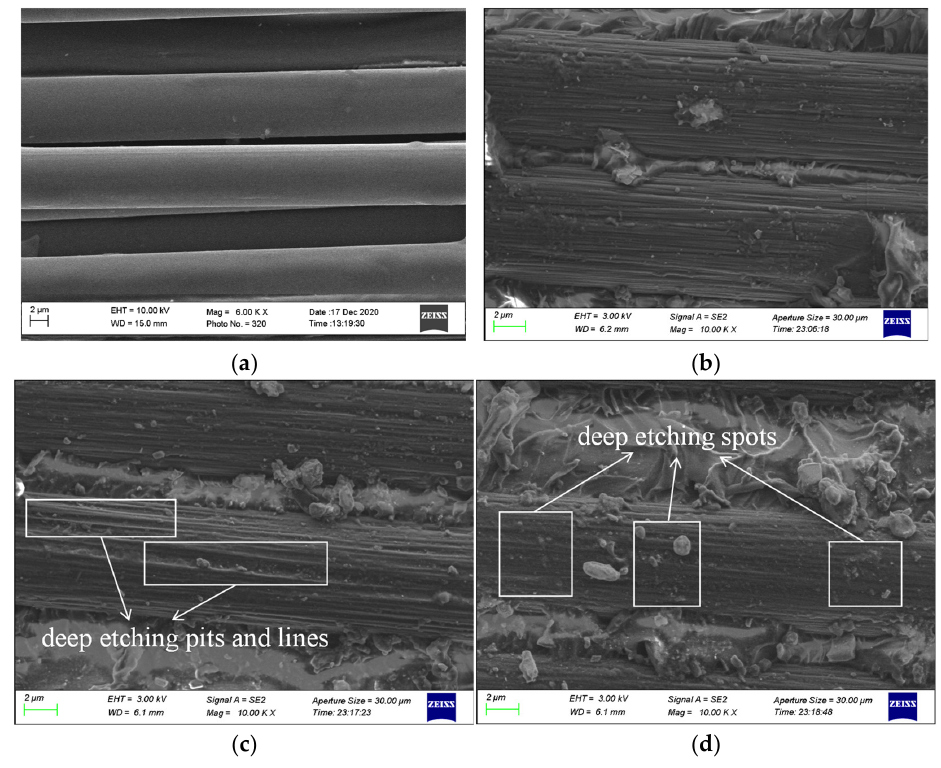
Figure 9. Surface morphology of CF/EP single-lap joints with different surface treatments. ( a ) Untreated, ( b ) sandblasting treatment, ( c ) plasma treatment for 50 s and ( d ) plasma treatment for 125 s. When the treatment time is extended to 125 s, the grooves and spots on the carbon fiber surface gradually widen, deepen and increase, more granular and linear protruding structures appear on the surface and the plasma etching marks become more